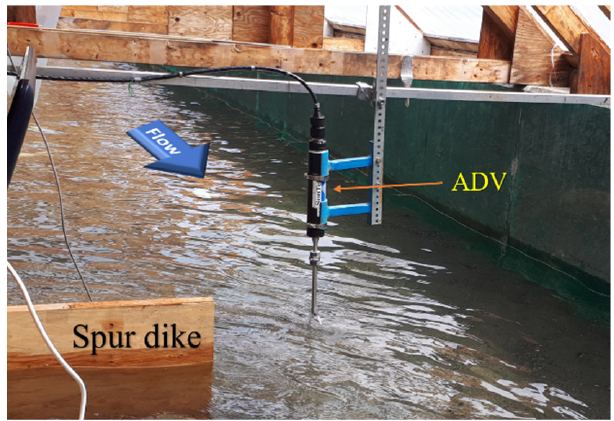
Figure 3. 3D Velocity data collection using the 10-MHz SonTek ADV.